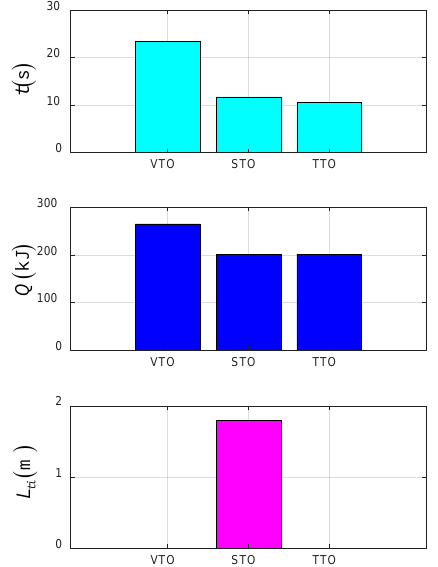
Figure 24. Comparison diagram of simulation results for three schemes.